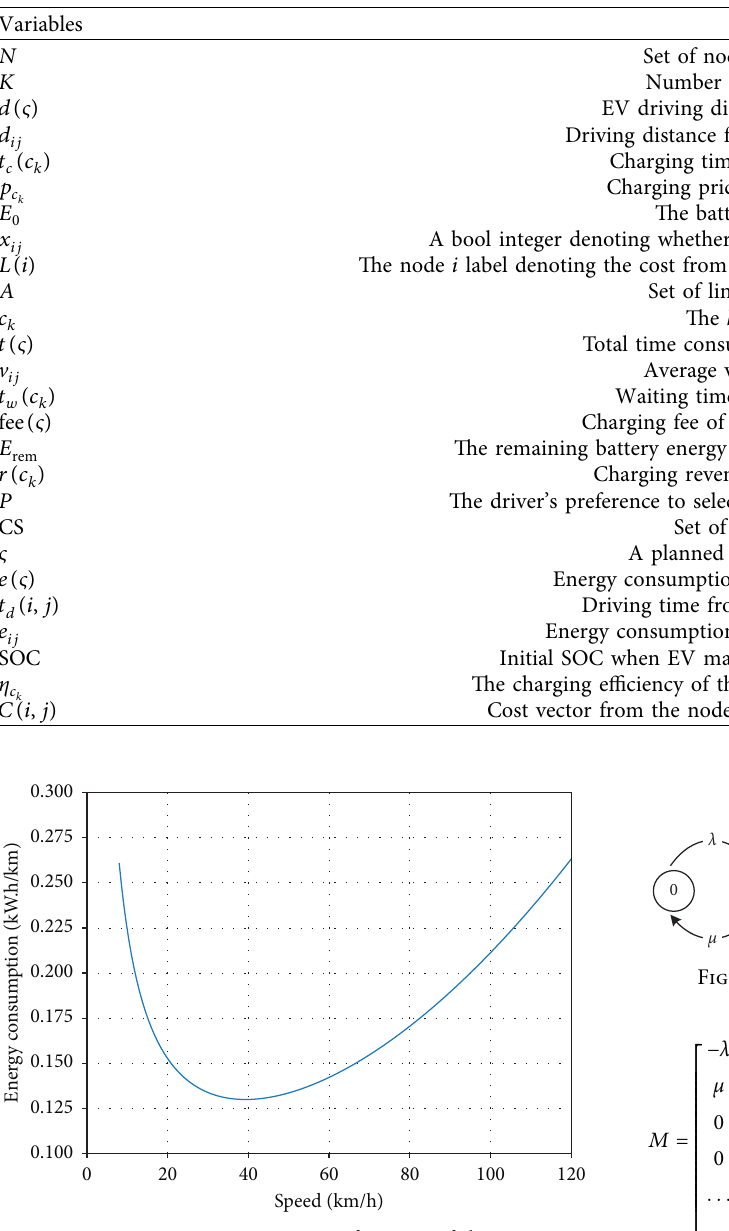
Table 1: The involved parameters in the EV charging path planning.